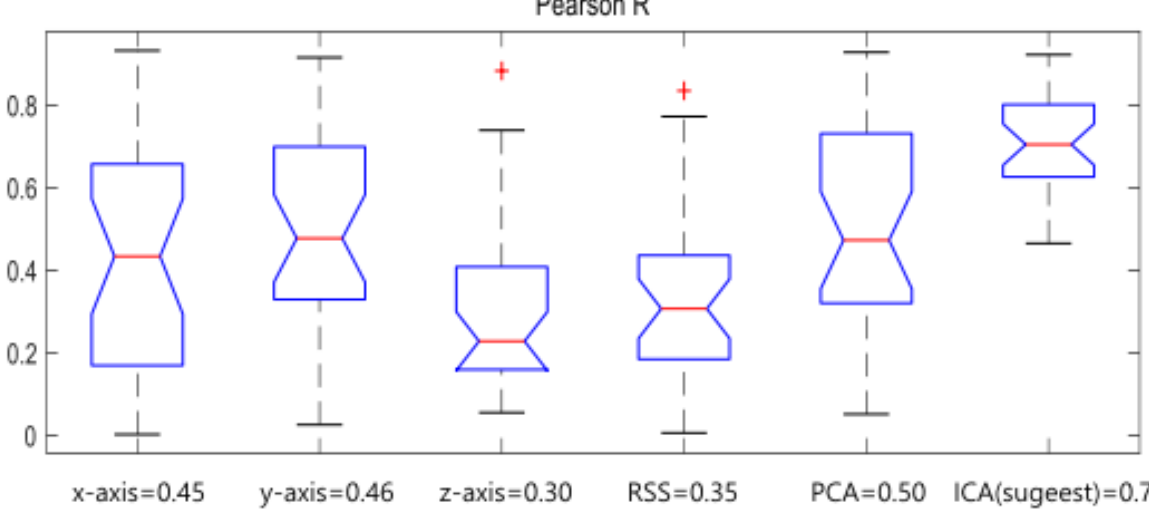
Figure 5. Skeletal box-and-whisker plot according to the calibration method. ICA: independent component analysis; PCA: principal component analysis; RSS: root sum square.